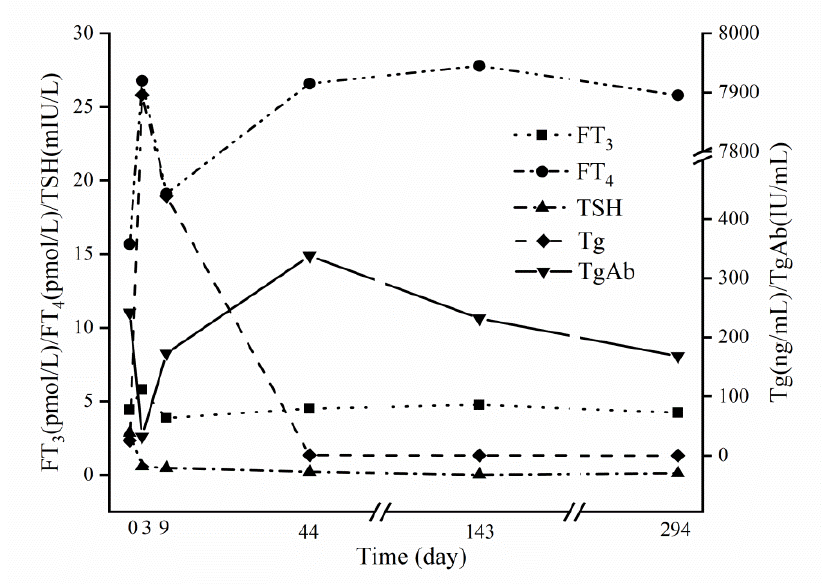
9 days ( C ) post 131 I administration.